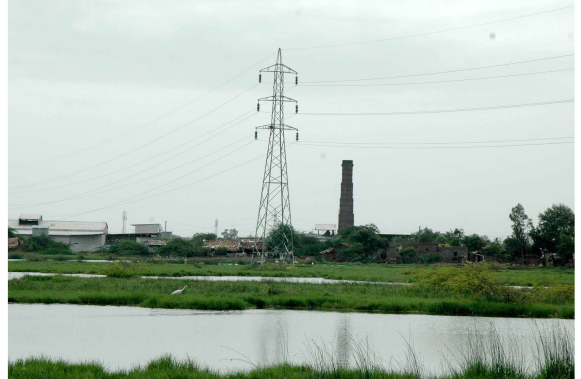
Image 2. Transmission line across wetland at Kumbharwada, Bhavnagar. Note thin earthing wire on top